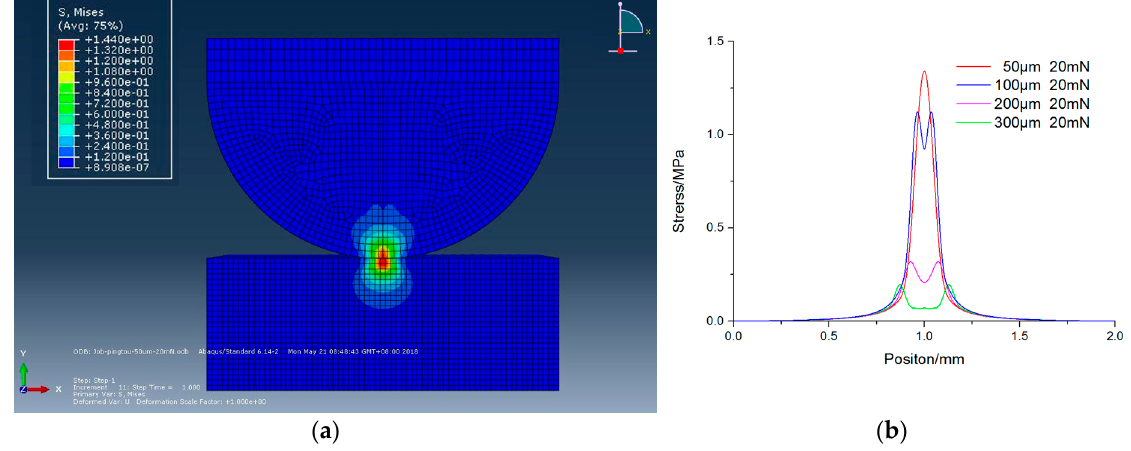
Figure 3. Stress distribution with tool wear at 20 mN ( a ) cross-sectional view with wear diameter of 100 μ m, and ( b ) with wear different diameters on workpiece surface.